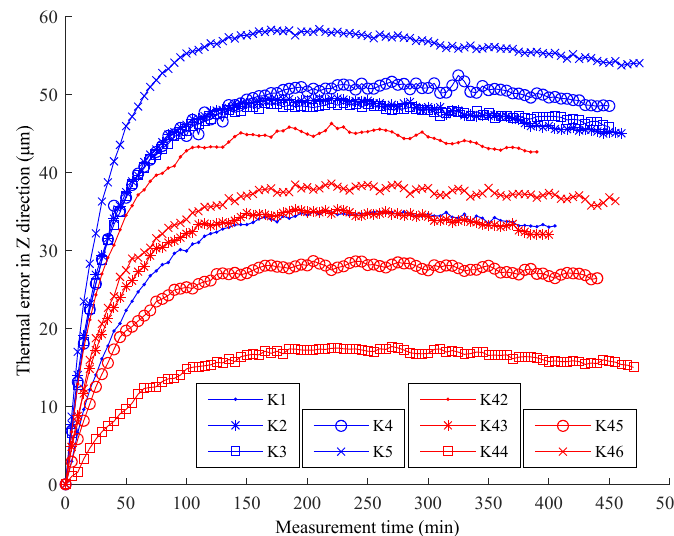
Figure 4. Thermal error curves of ten batches of experiments.